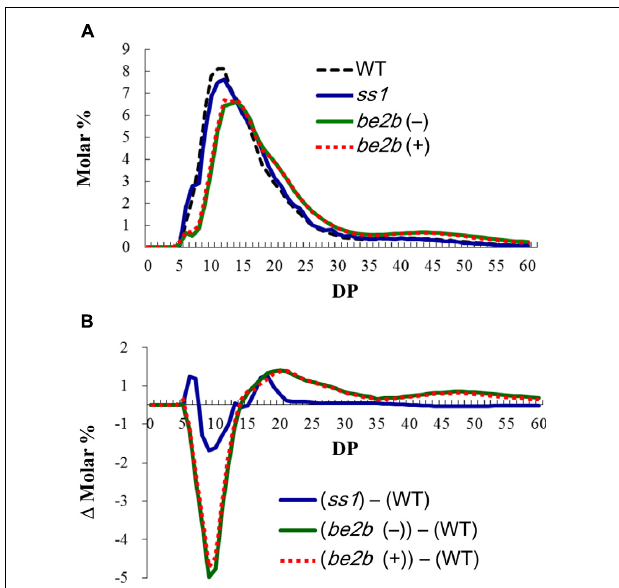
FIGURE 1 | Amylopectin structure of the ss1 null mutant and two be2b mutants analyzed by capillary electrophoresis following debranching the endosperm starch with isoamylase. (A) Chain length distribution patterns of WT (Nip) in black dotted line, ss1 null mutant in blue, and be2b mutants; (–), EM10 in green, which lacks BEIIb protein; (+), # 1411 in red dotted line, which produces inactive BEIIb protein. (B) The detailed differences of the chain length distribution patterns shown as (cid:49) molar % by subtracting the data of WT (Nip) from that of the ss1 or be2b mutant lines.